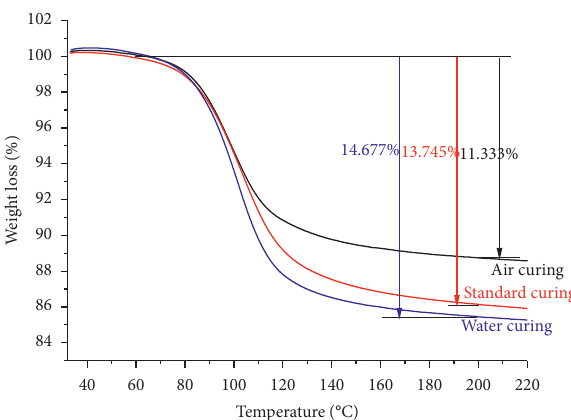
Figure 5: TG curves of MPC with the M / P ratio of 3:1 under various curing conditions after curing for 3d.